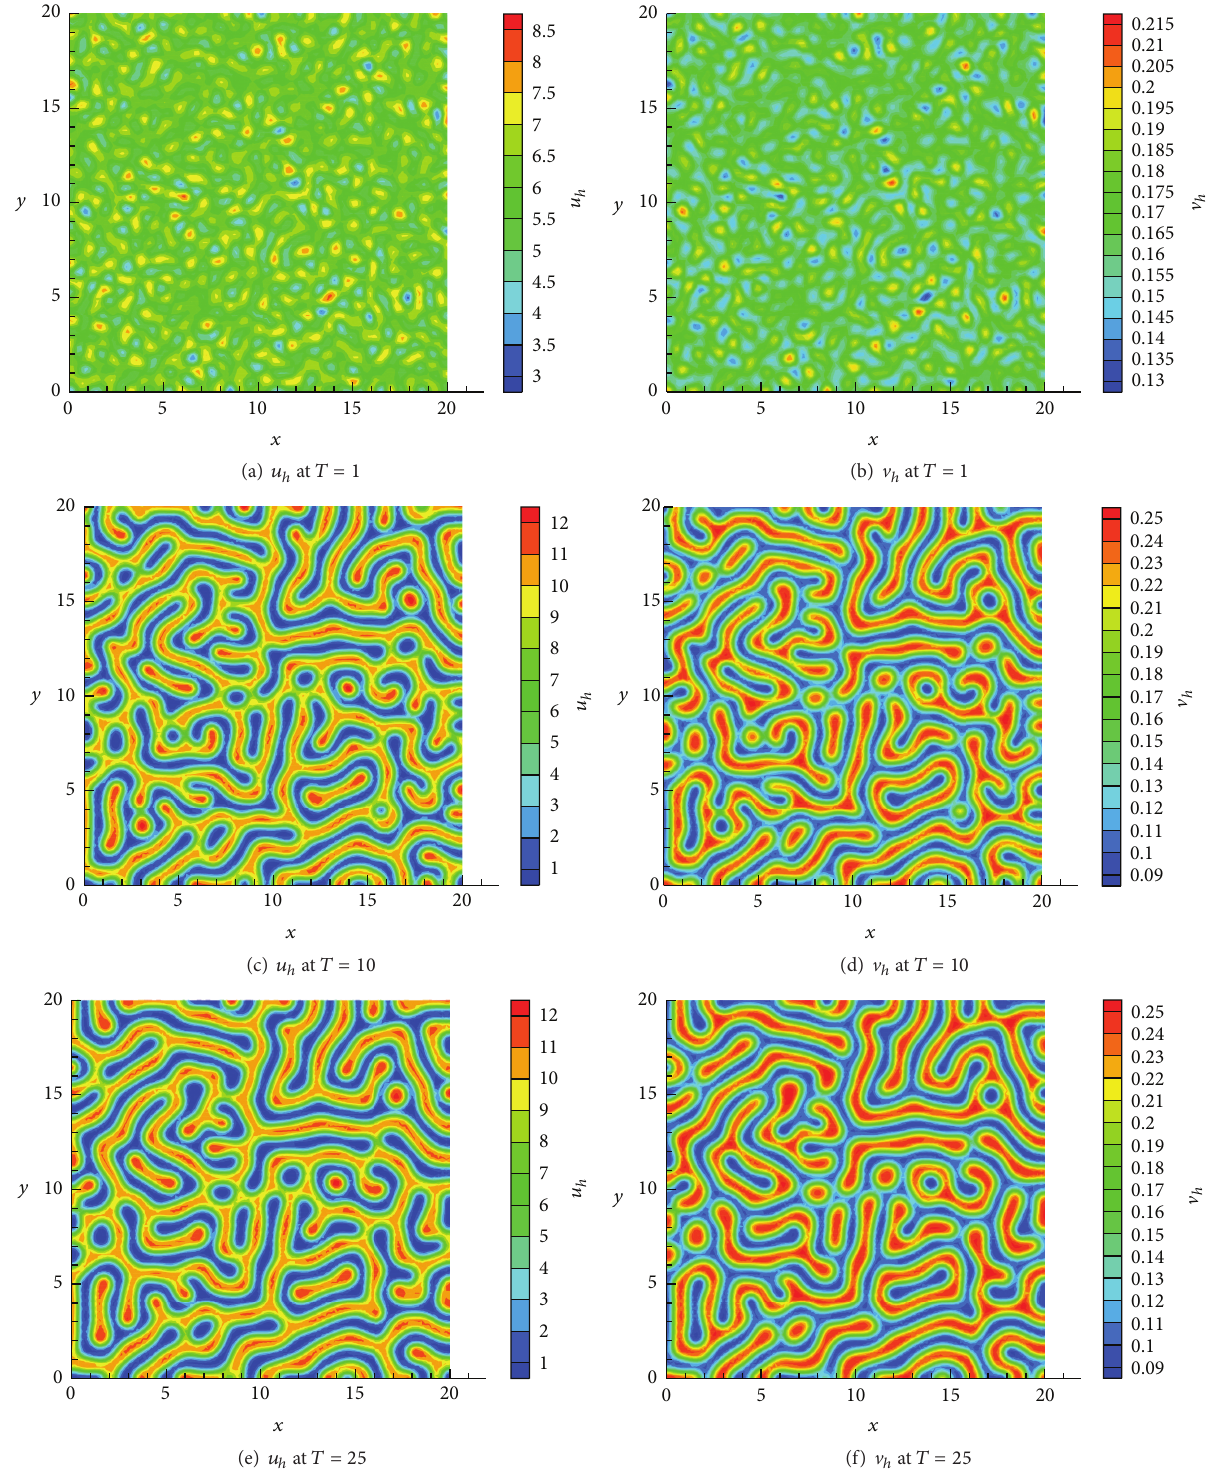
Figure 7: The time evolution of numerical solutions 𝑢 ℎ (left) and V ℎ (right) on the square domain with 𝑏 12 = 32